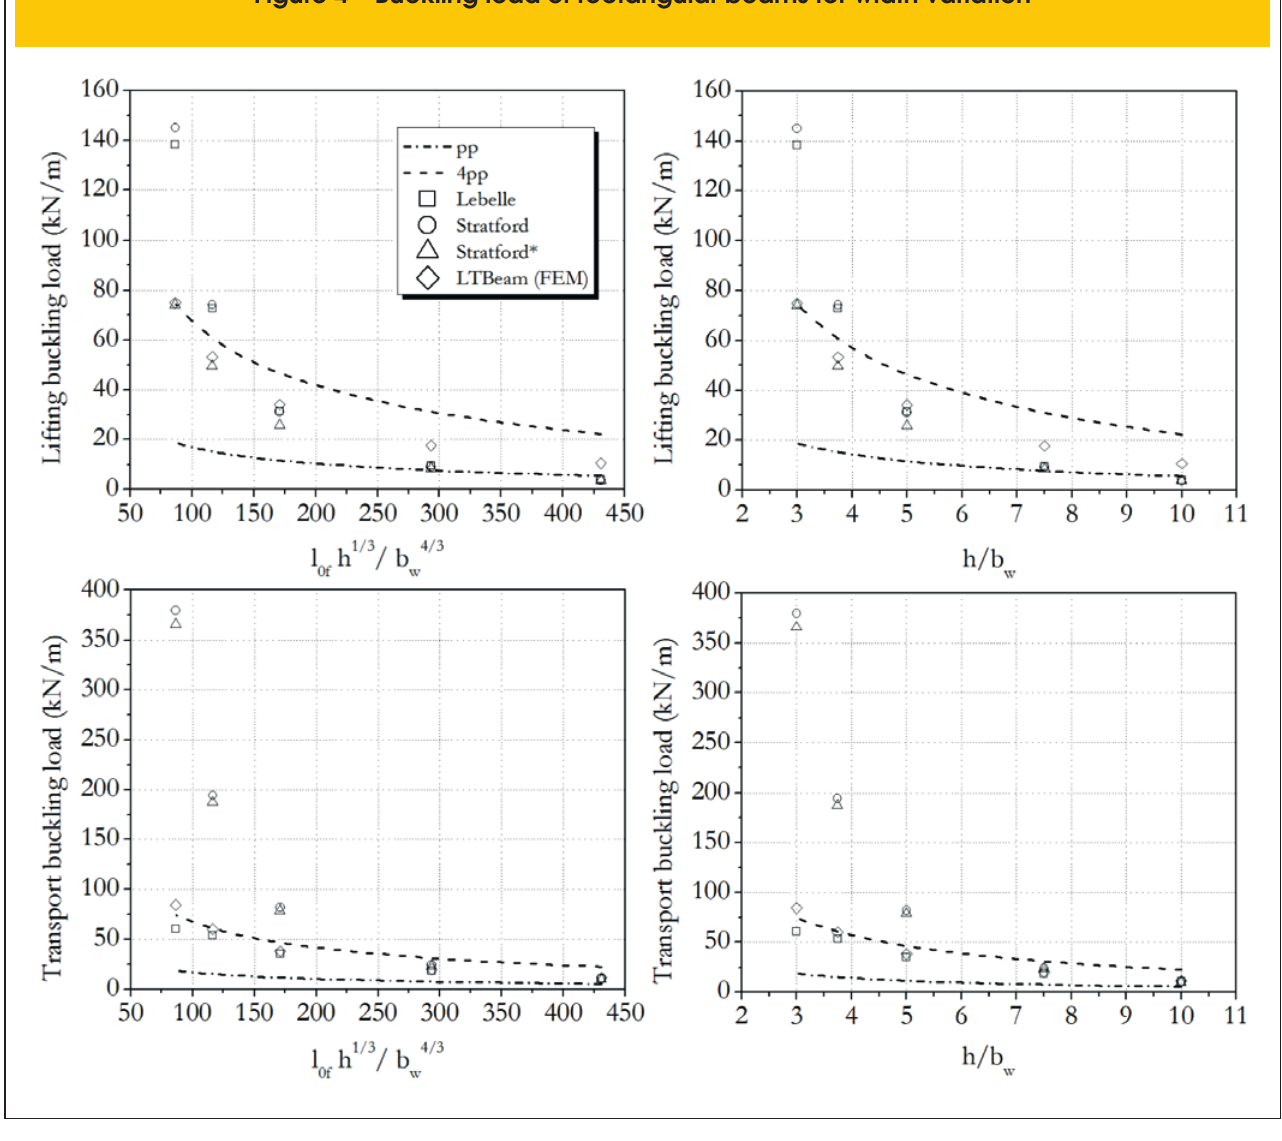
Figure 4 – Buckling load of rectangular beams for width variation